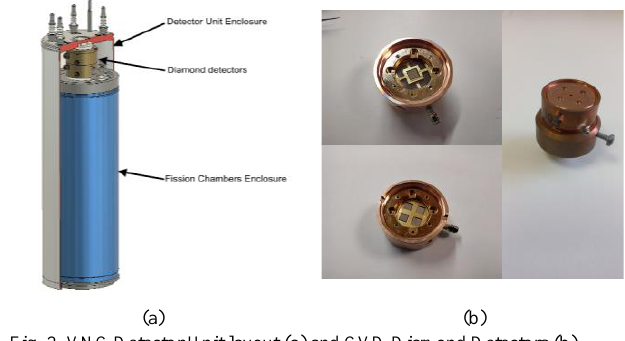
Fig. 2. VNC Detector Unit layout (a) and CVD Diamond Detectors